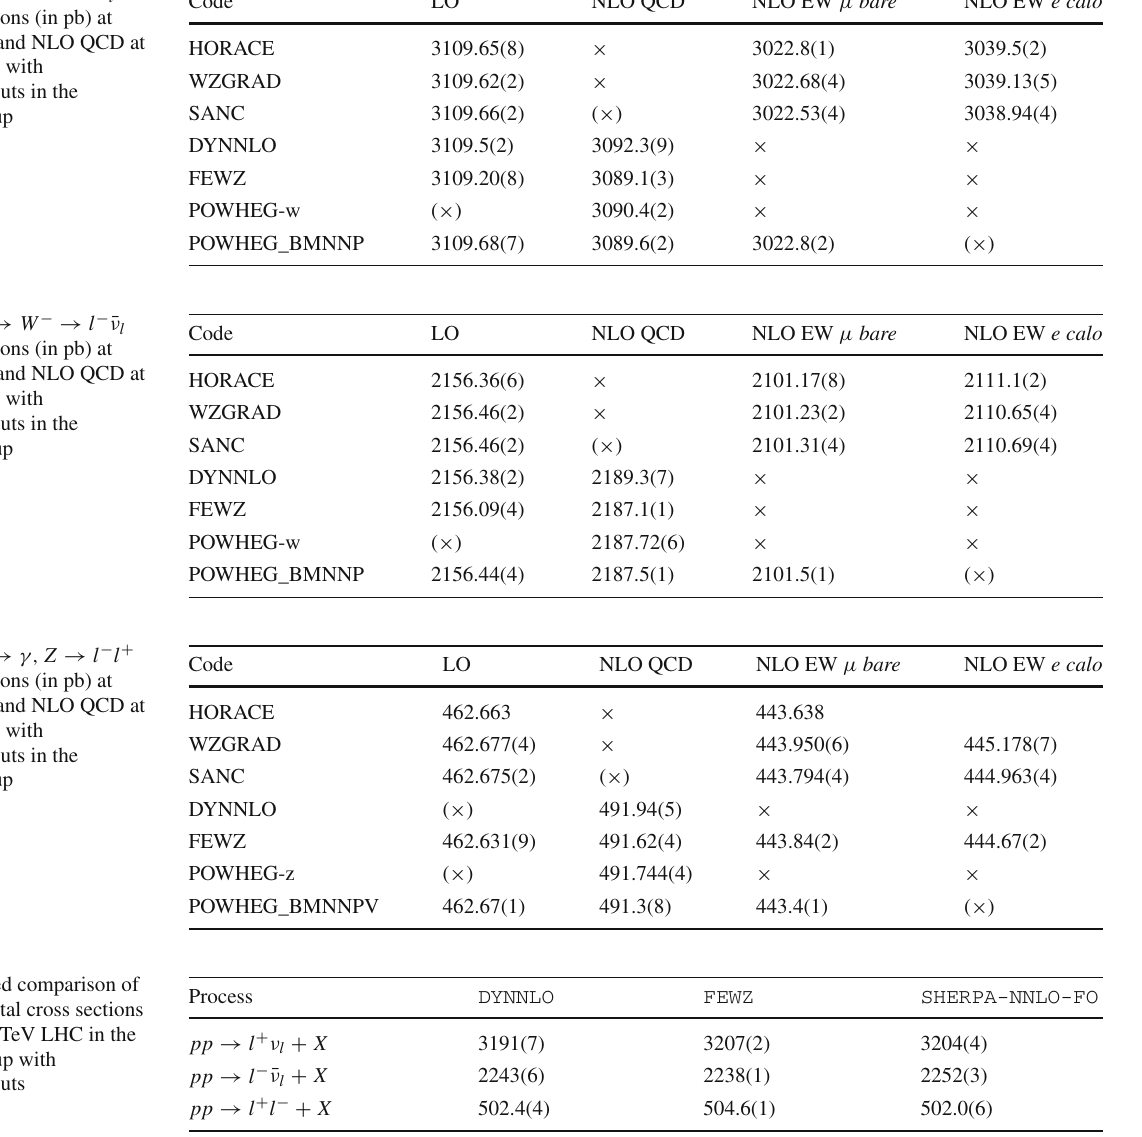
Table 9 pp → W + → l + ν l total cross sections (in pb) at LO, NLO EW and NLO QCD at the 8 TeV LHC with ATLAS/CMS cuts in the benchmark setup